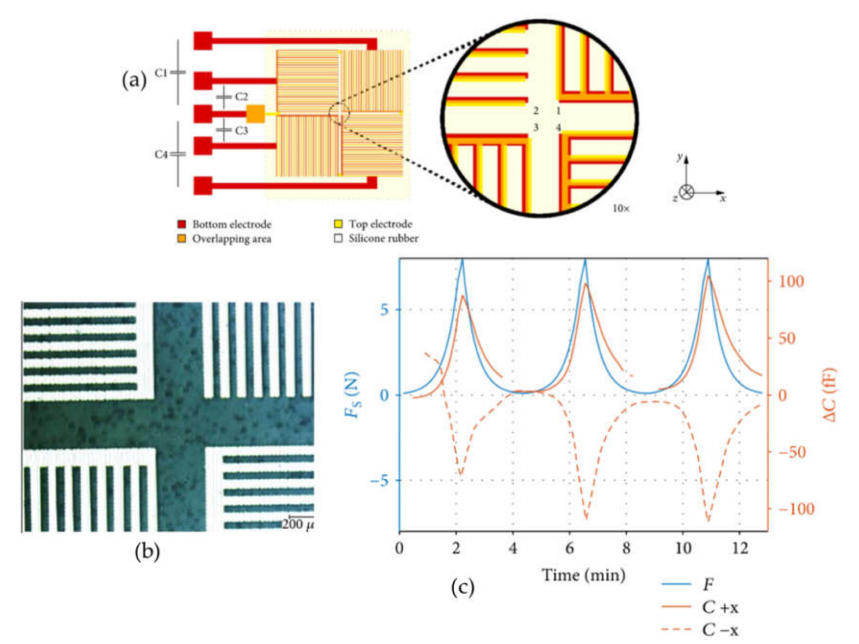
Figure 3. ( a ) Design of printed shear force sensor from [99]; ( b ) Image of the inkjet silver electrodes; ( c ) Capacitance response (red) to a normal force (blue) over time. ( b ) The solid red line corresponds to the capacitance change due to a force in – direction and the dashed line to the +